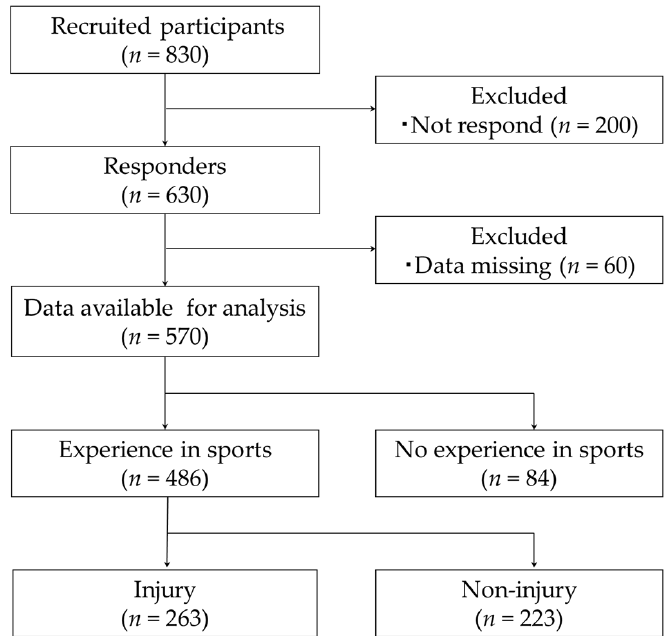
Figure 1. Flowchart of the selection of study participants.